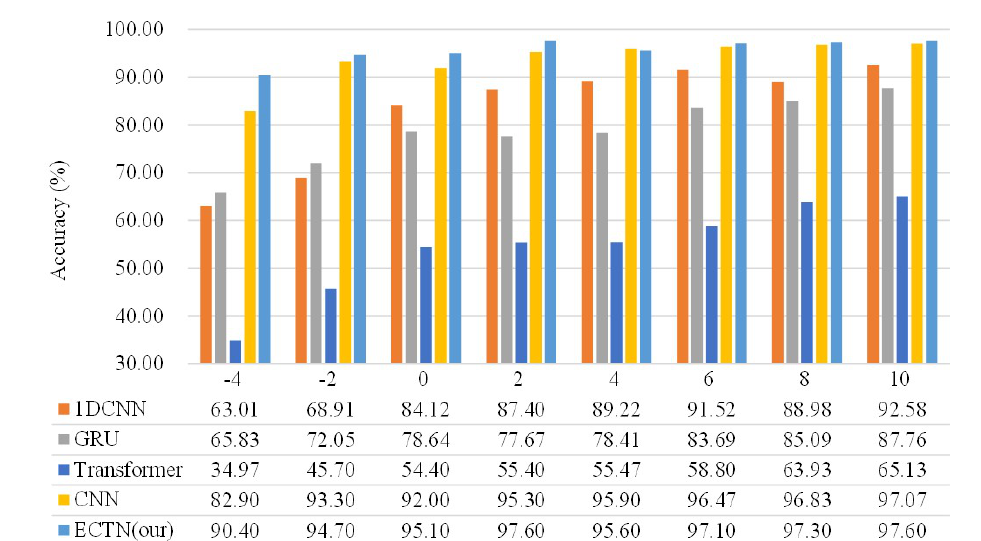
Figure 10. Average diagnostic accuracy for different fault diagnosis methods under different